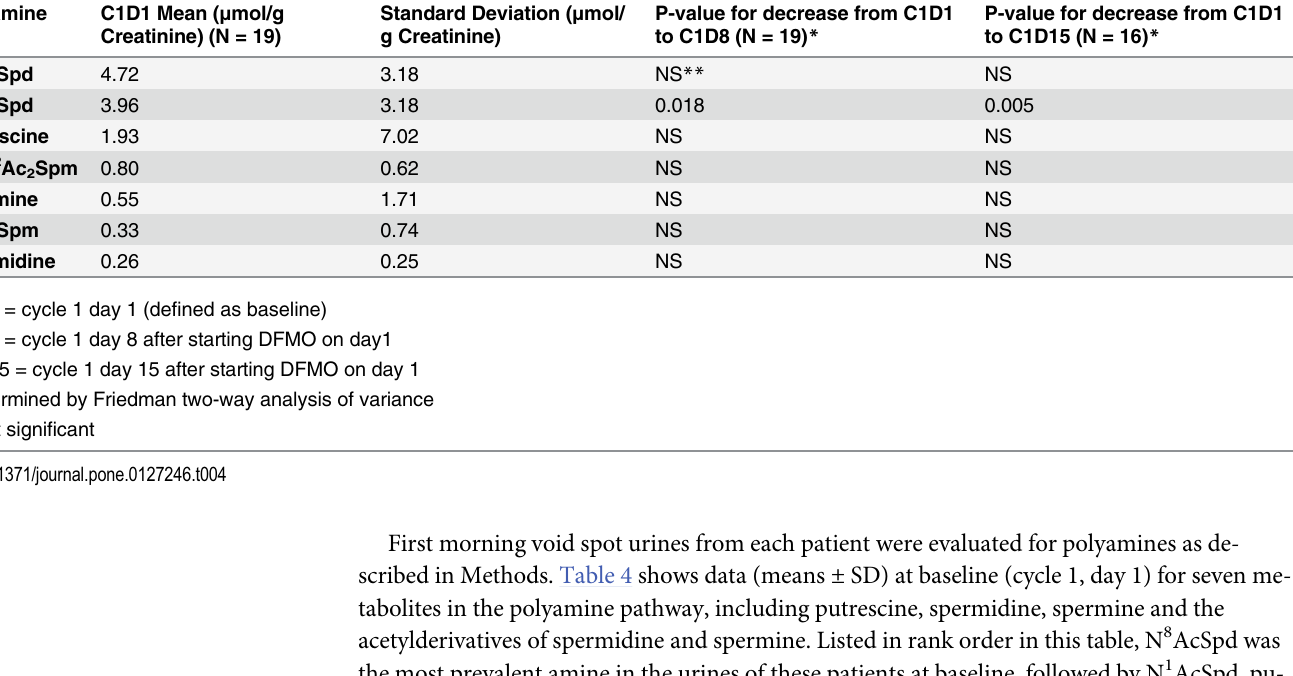
Table 4. Urinary polyamine metabolites from patients at baseline and during first two weeks of DFMO therapy.